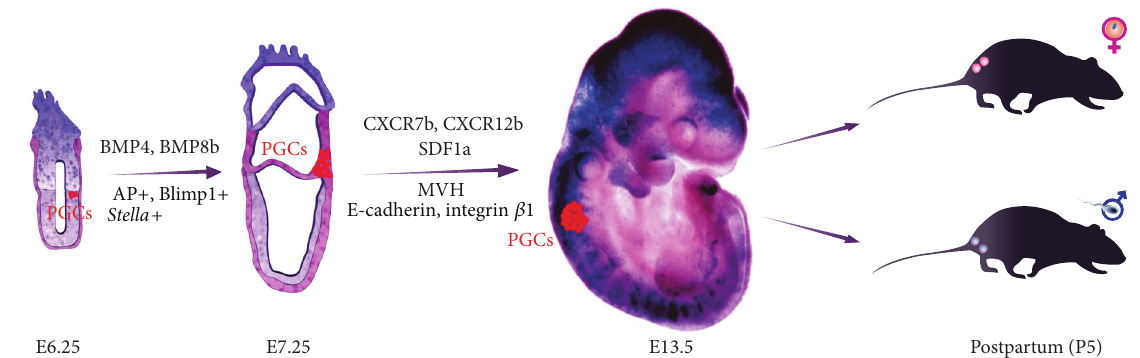
Figure 1: Time schedule and signals involved in the regulation of primordial germ cells (PGCs) migration and colonization in